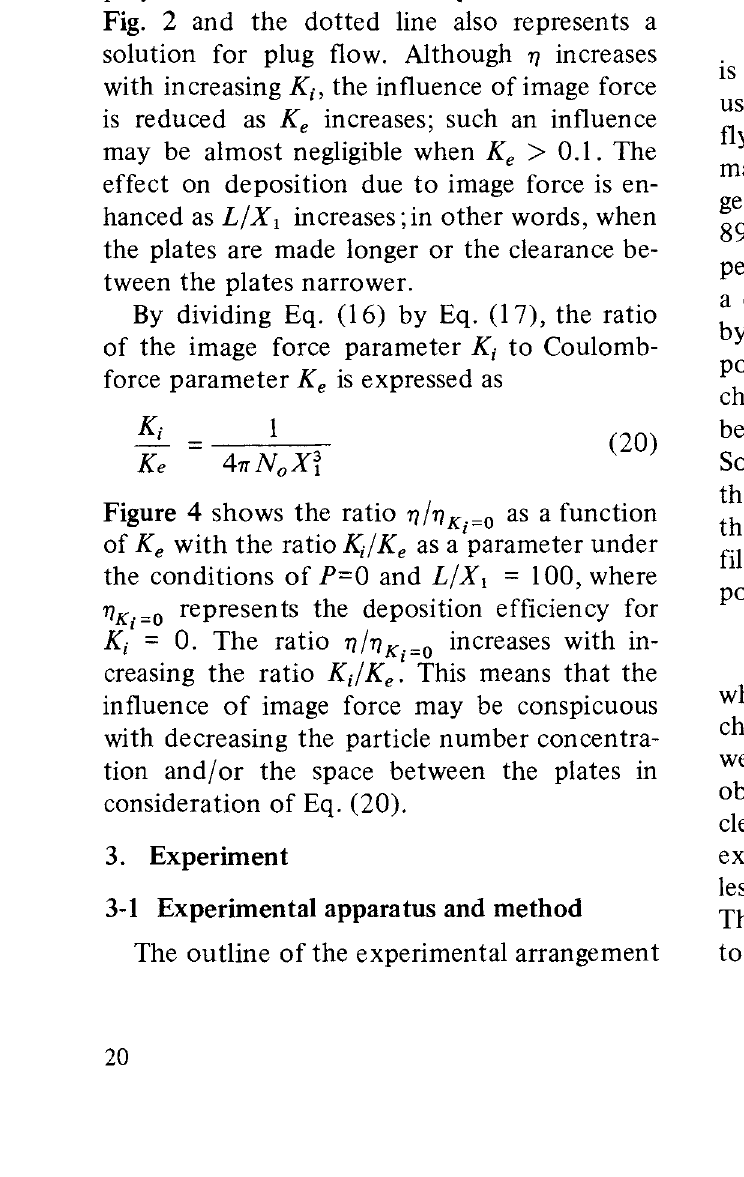
Fig. 4 Deposition efficiency-ratio 71/TIKi=O as a function of